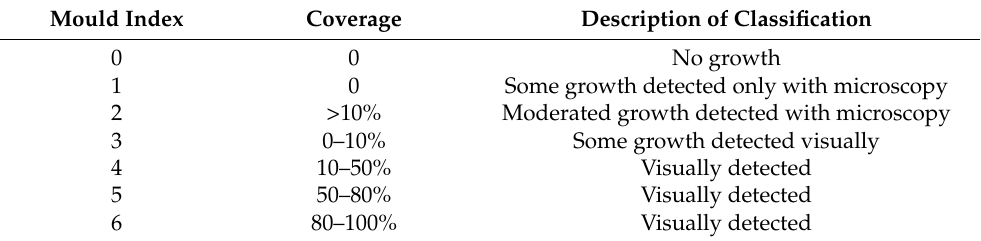
Table 4. Mould indexing classifications (adapted from [35]).